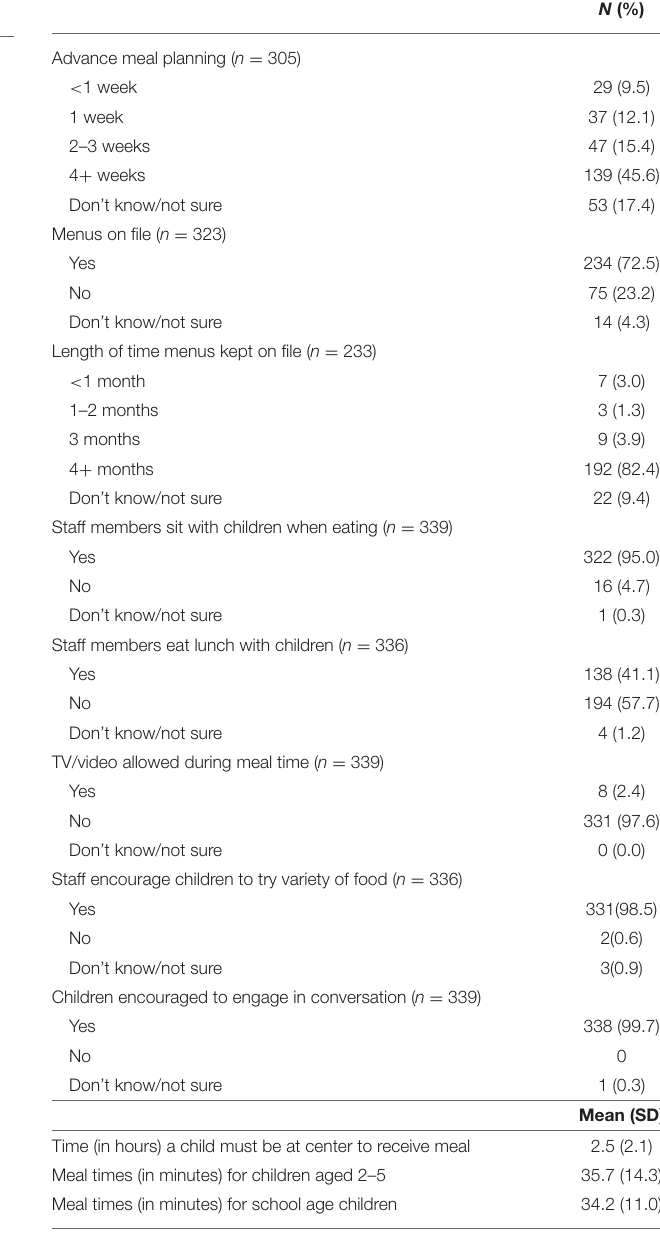
TABLE 2 | General characteristics of Colorado Childcare Regulations Survey participants.